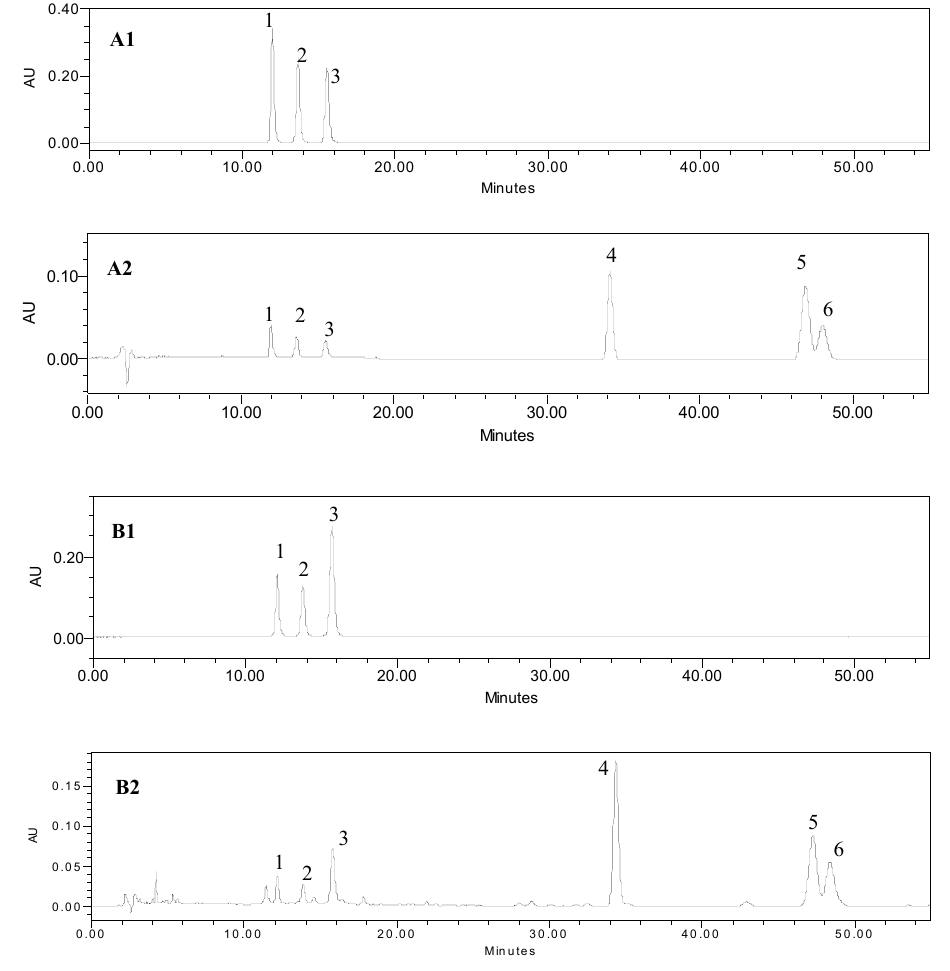
Figure 2. HPLC chromatograms of the mixed standards solution ( A1 : 430 nm, A2 : 240 nm) and turmeric sample ( B1 : 430 nm, B2 : 240 nm). The peaks were numbered the same as those in Figure 1.